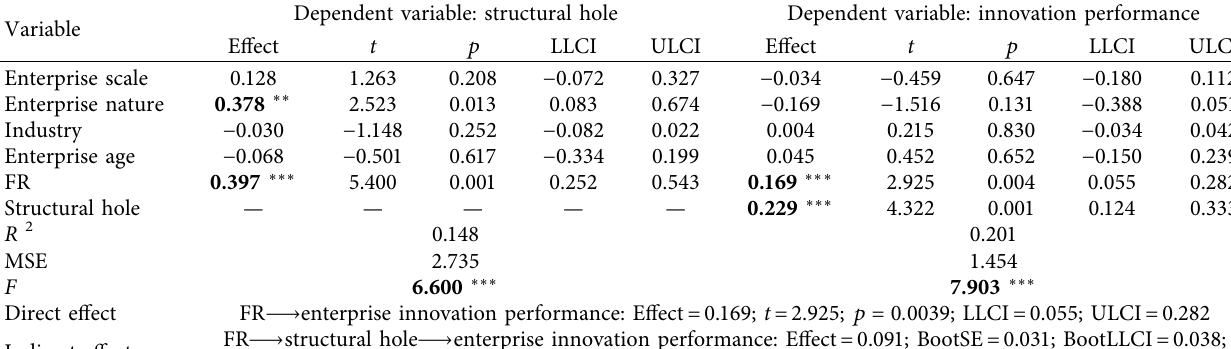
Table 6: Te result of “Model 4.”